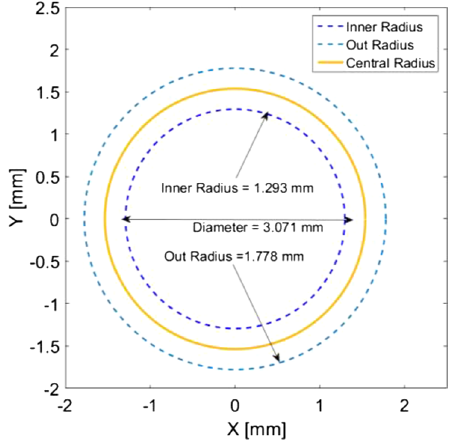
FIG. 7. Hollow electron beam geometry